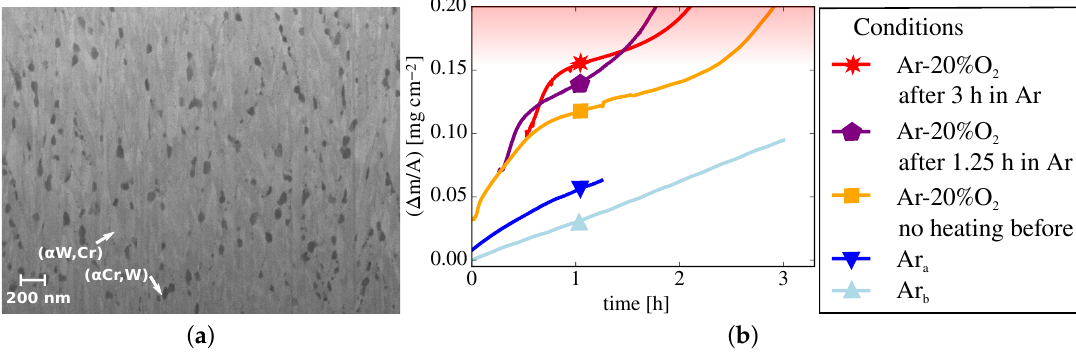
Figure 7. ( a ) Microstructure of a W-12Cr-0.5Y alloy after 3h annealing in Ar; ( b ) Mass change with respect to time of W-12Cr-0.5Y samples at 1273K. The oxidation behavior after 0min, 75min, and 180min annealing in Ar is